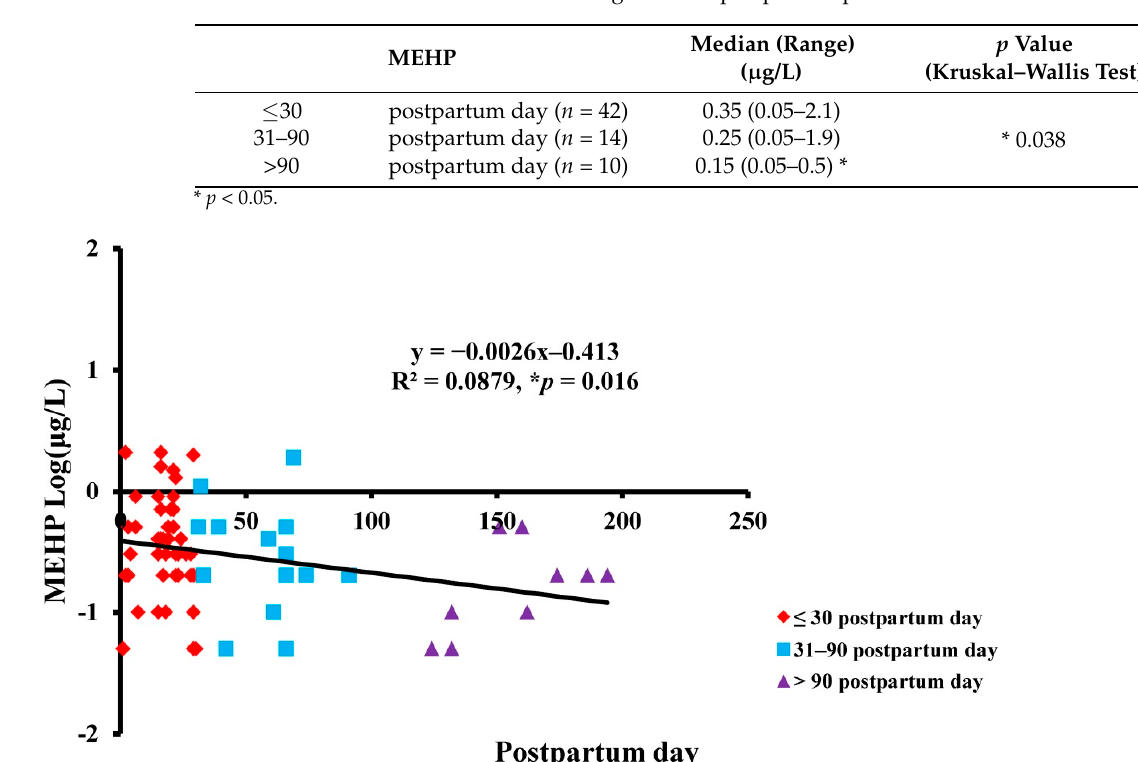
Figure 1. The negative correlation between MEHP level in breast milk and postpartum period. The human milk from different time periods postpartum is labeled with different markers. Red diamonds indicate <30 days postpartum, blue squares indicate 30–90 days postpartum, and purple triangles indicate >90 days postpartum. * p < 0.05 is considered sig- nificant using linear regression. y = − 0.0026x − 0.413, R 2 = 0.0879, and r = − 0.016.